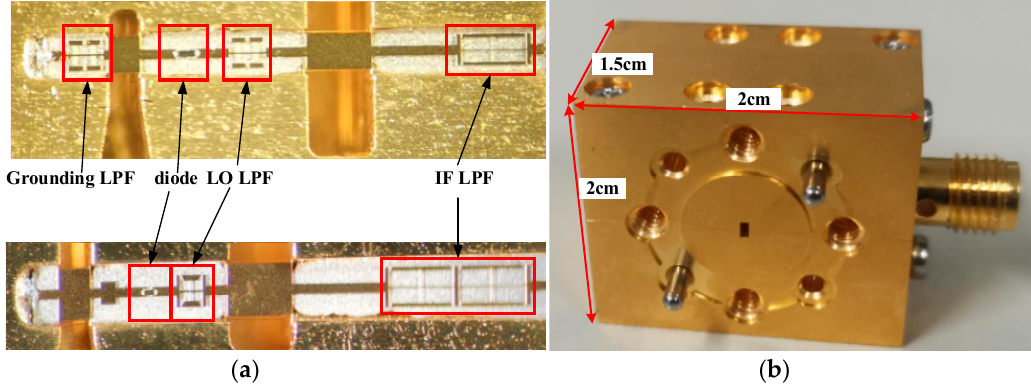
Figure 11. ( a ) Quartz circuit in the mixer’s block. ( b ) Photography of the entire block.